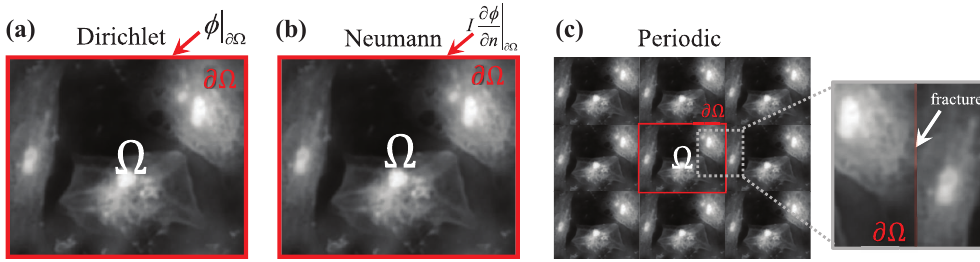
Figure 14. Three typical boundary conditions used in TIE solvers: ( a ) Dirichlet boundary conditions (need to know the phase value at the boundary); ( b ) Neumann boundary conditions (need to know the phase normal derivative at the boundary); and ( c ) periodic boundary conditions (assume the object is periodically extended at the boundary).